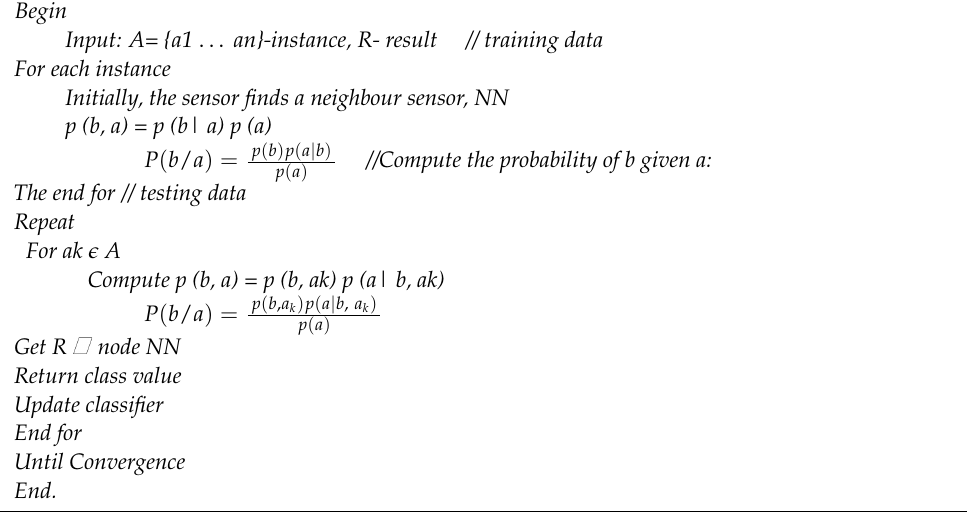
Algorithm 1: Algorithm for Collecting Data from IoT Sensors in Smart